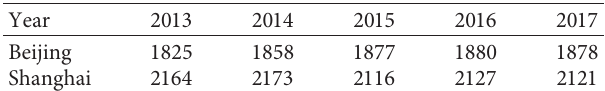
Table 4: Population of Beijing and Shanghai from 2013 to 2017 (unit: ten thousand).